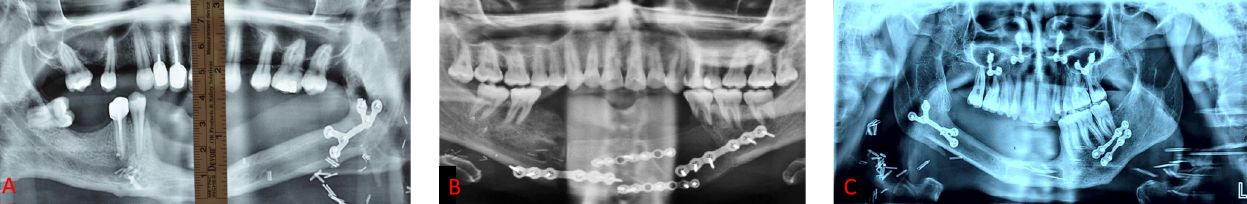
Fig. 2. Residual bone height mean of 12mm (A: patient n ° 1), 15mm (B: patient n ° 2), and 12mm (C: patient n ° 3).